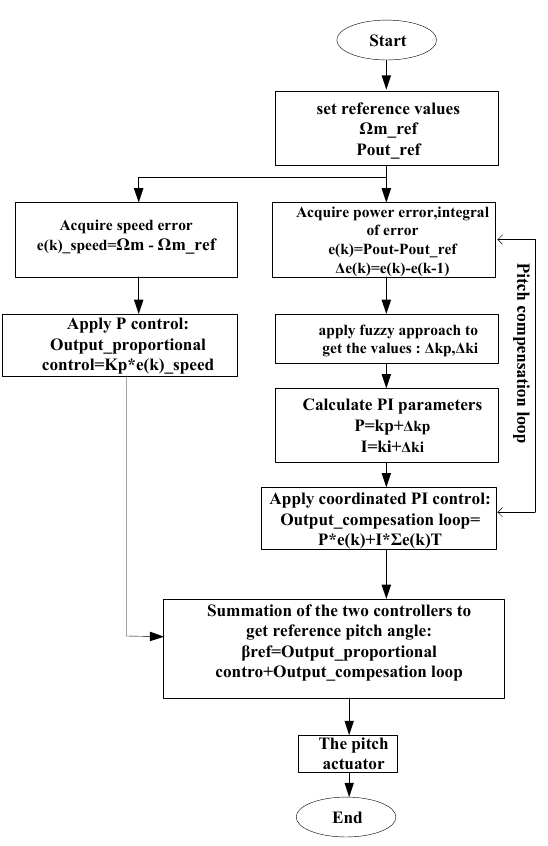
Figure 8. Flow chart of the proposed control.